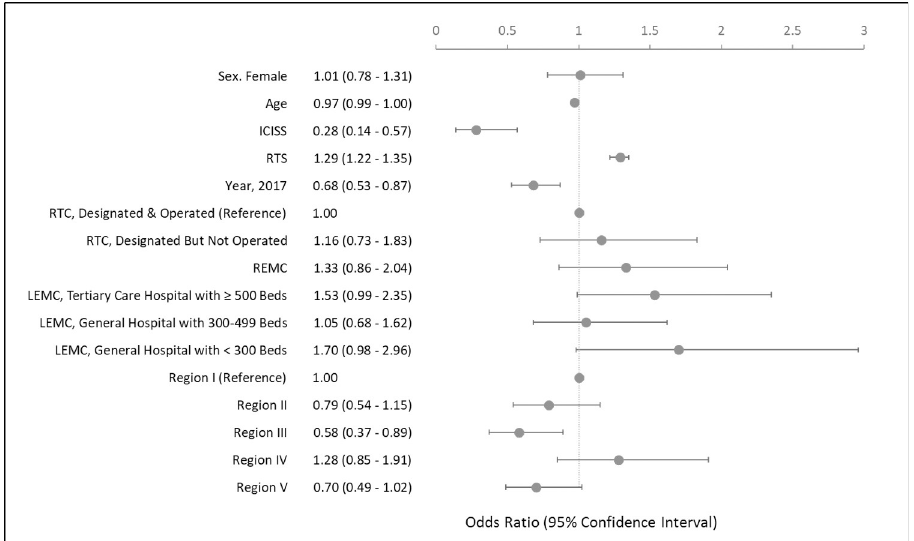
Fig 4. Multivariate analysis of risk factors for preventable trauma deaths. Baseline characteristics were compared between two groups using the chi-square or Fisher’s exact tests. Logistic regression was used to explain the relationship between preventable trauma deaths and influencing factors. We confirmed that the goodness of fit for logistic regression was satisfactory using the Hosmer–Lemeshow test. Two-sided P values of 0.05 or less were considered to indicate statistical significance. The likelihood of preventable trauma death according to related factors was expressed as odds ratios and 95% confidence intervals relative to the reference value. ICISS, International Classification of Disease Injury Severity Score; RTS, Revised Trauma Score; RTC, Regional Trauma Center; REMC, Regional Emergency Medical Center; LEMC, Local Emergency Medical Center.